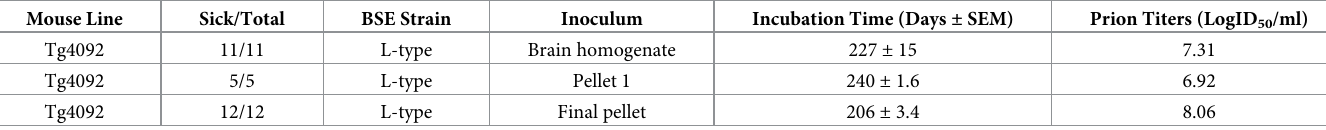
Table 2. Infectivity of the purified L-type BSE samples. Intracerebral inoculation of transgenic mice with the BSE prion samples obtained during purification experiments. Mouse